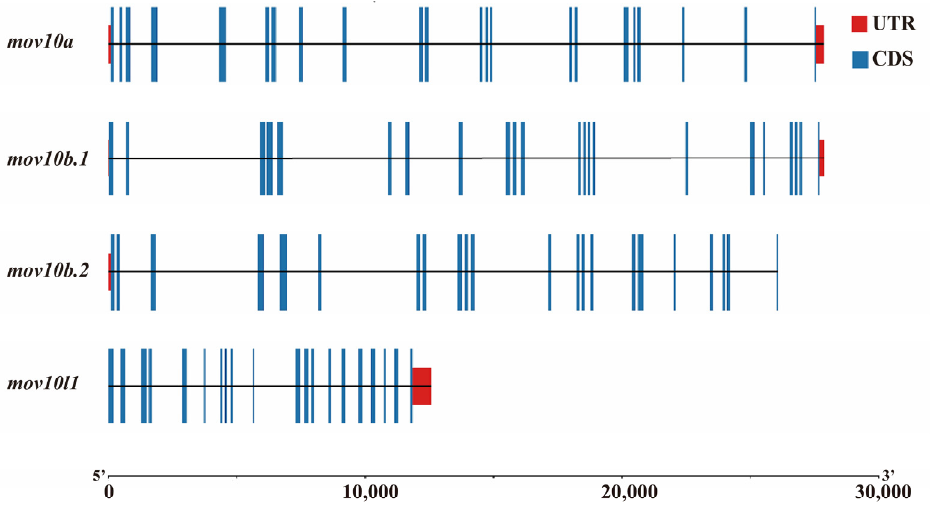
Figure 3. The intron-exon structures of the mov10s and mov10l1 genes in zebrafish. The blue boxes denote the gene coding regions, the red boxes mean the untranslated region, and the lines represent the introns. The graduated line at the bottom shows the length of the genes.